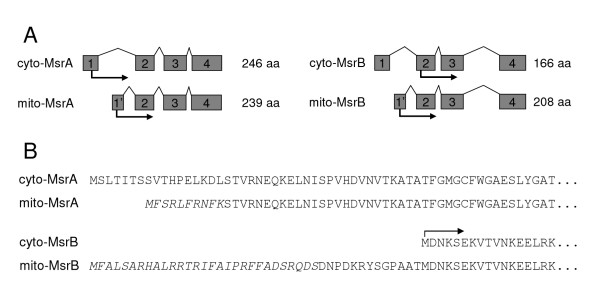
Alternative splicing of D. melanogaster MsrA and MsrB genes. (A) Genomic structures of Drosophila MsrA and MsrB genes. Translation initiation sites are indicated by arrows. Boxes indicate exons, which are numbered. Upper images show organization of the cytosolic forms of MsrA (left) and MsrB (right), respectively, and lower images of the mitochondrial forms of these proteins. (B) N-terminal amino acid sequences of alternatively spliced variants of MsrA and MsrB. Arrow indicates initiation of translation of cytosolic MsrB. However, this methionine is an internal residue in the mitochondrial MsrB form. Mitochondrial signal peptides are shown in italics.